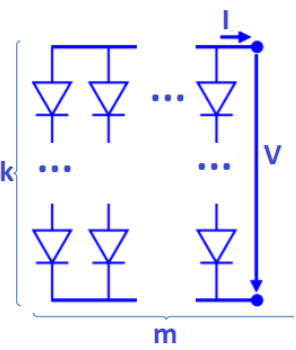
Figure 15. A schematic of a k × m photovoltaic